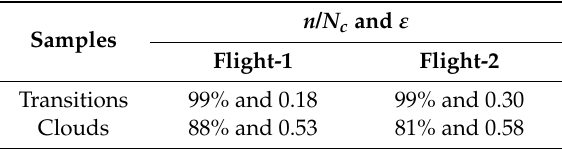
Table 2. The number concentration ratios of the small droplets with radii from 1 to 5.5 µ m to all droplets ( n / N c ) and dispersion ( ε ), in the transitions and clouds, respectively. n / N c and ε Samples Flight-1 Flight-2 Transitions 99% and 0.18 99% and 0.30 Clouds 88% and 0.53 81% and